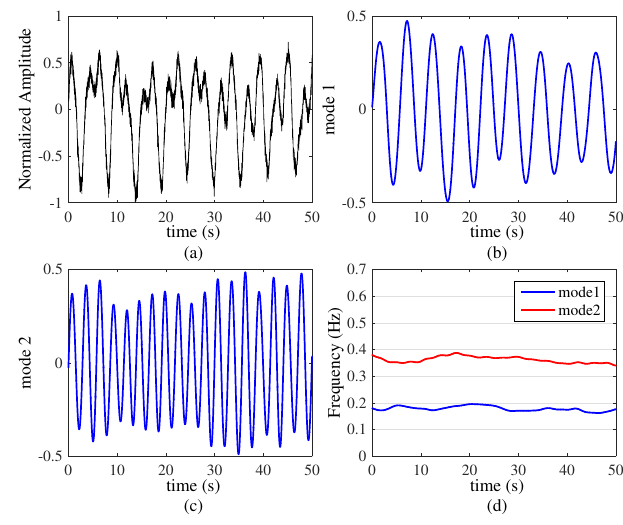
Figure 5. Two targets with constant respiration rates ( k = 2, α = 20,000). ( a ) Original signal; ( b ) and ( c ) are two modes decompose by VMD based algorithm; ( d ) is the time-varying respiration signal.